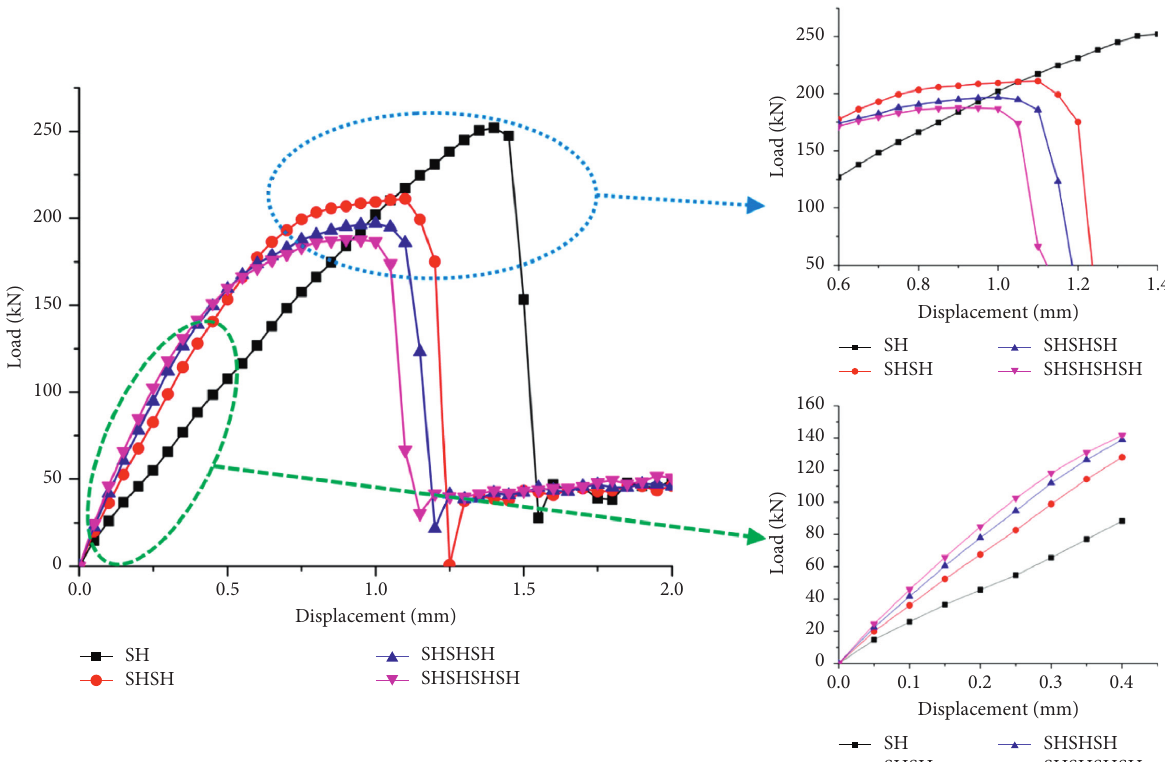
Figure 20: Influences of the layer number on the load-displacement